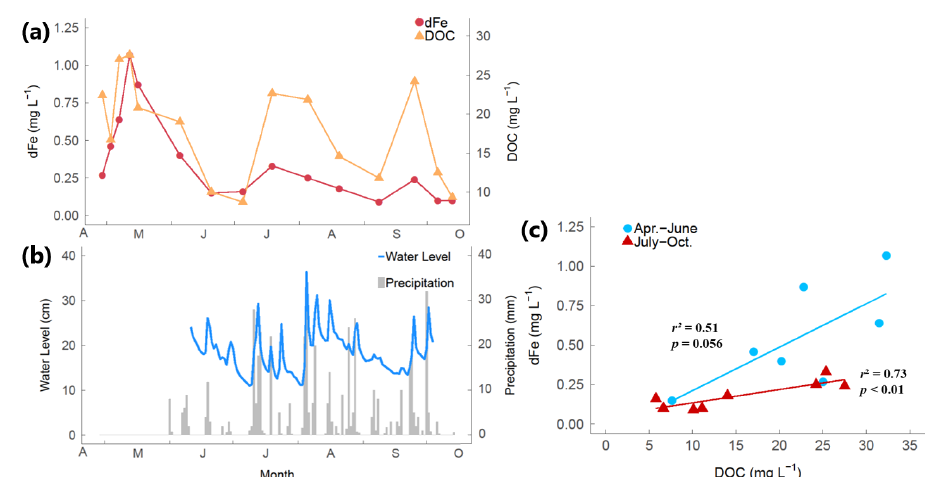
Figure 3. ( a ) seasonal changes in dFe and DOC concentrations in the Sofron River; ( b ) daily change in water level of the Sofron River and daily amount of rainfall in the Tyrma region; ( c ) liner regression plot of DOC and dFe concentrations in the Sofron River. Blue circles show the data from April to June (first seven samples in ( a )), and red triangles show the data from July to October (late nine samples in ( a )). The regression lines were calculated by the least squares method.